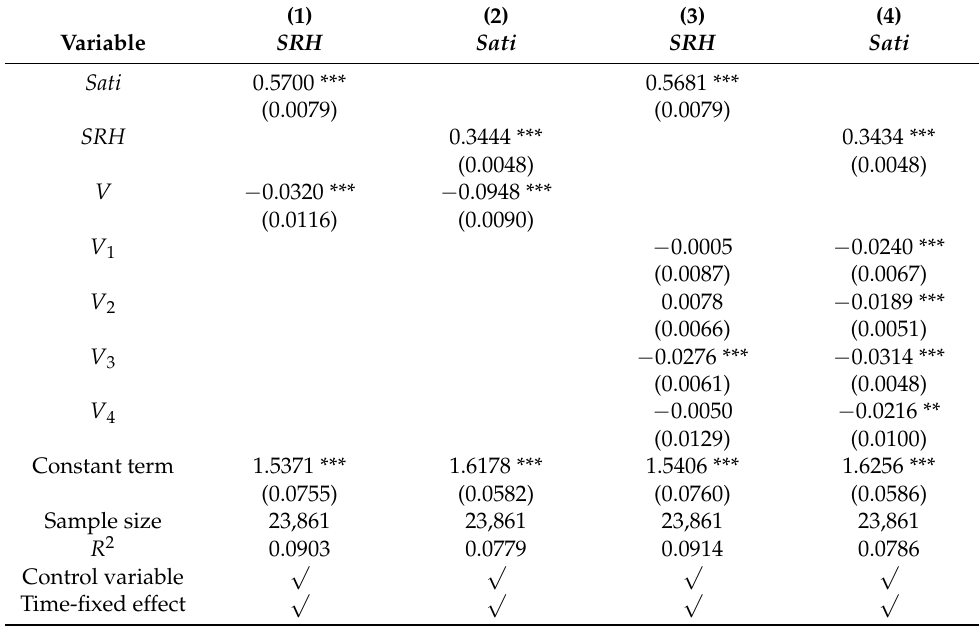
Table 6. Estimated results of domestic violence, health and life